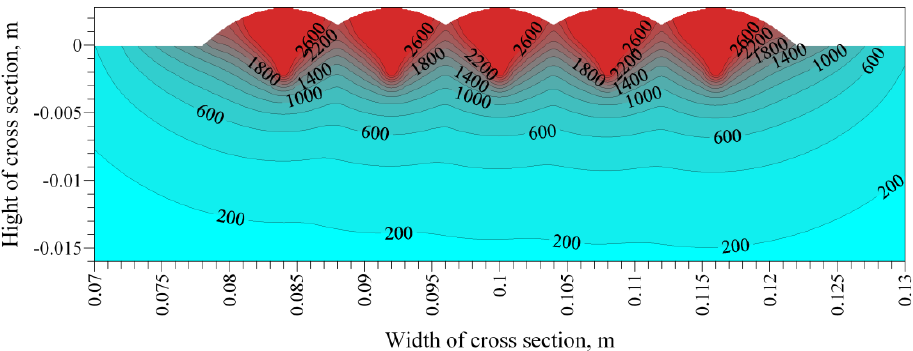
Figure 16. Heat ‐ affected zone.